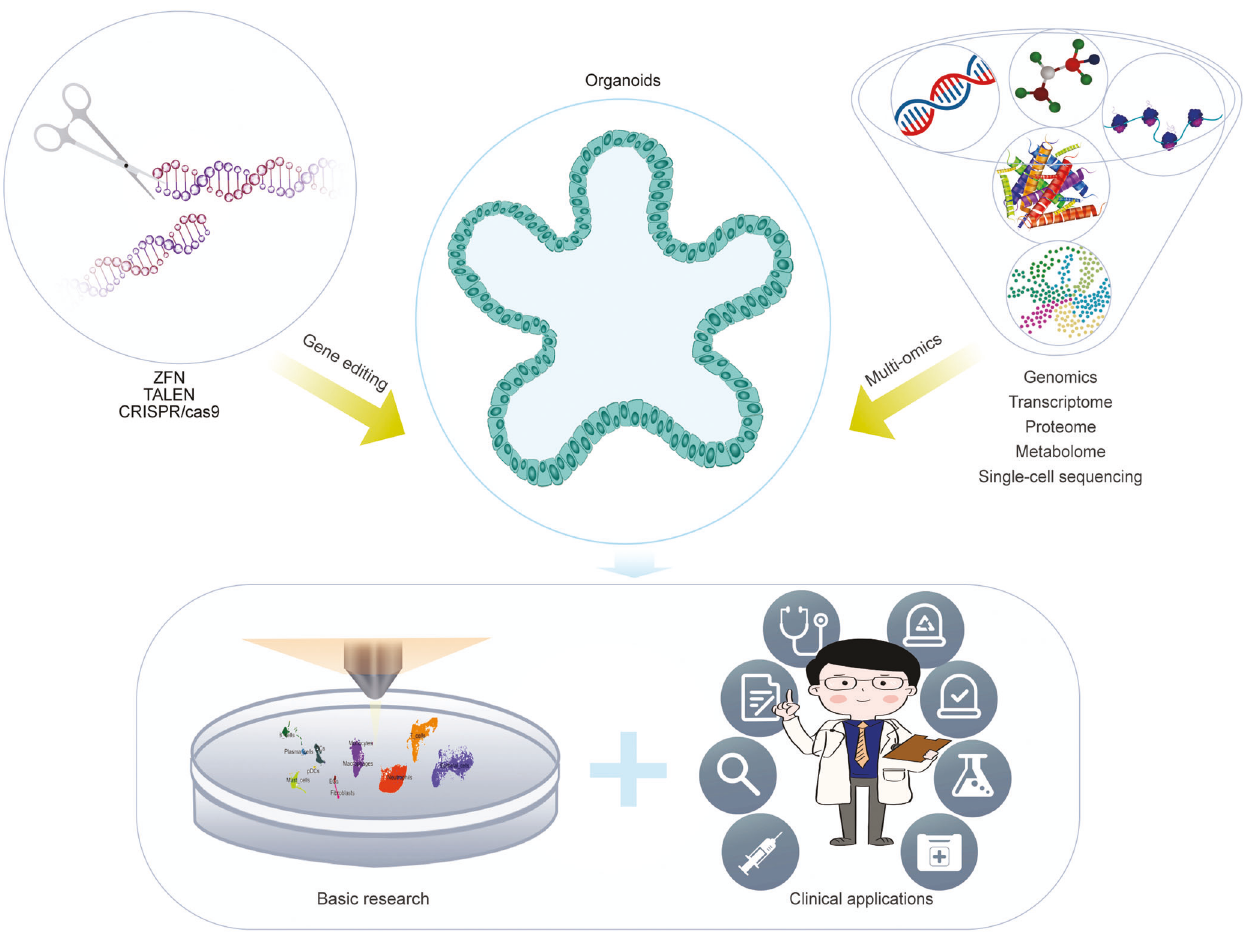
Fig. 6 The prospect of combining high-technology approaches and digestive organoids. Gene editing and omics (epigenetics, transcriptomics, proteomics, metabolomics, and single-cell sequencing) technologies are used in combination with organoid models to systematically and comprehensively analyze molecular, cellular, and histological changes mediated by gene mutations or environmental interventions. Starting from basic research, the in vivo phenotypes and molecular targets corresponding to organoids under